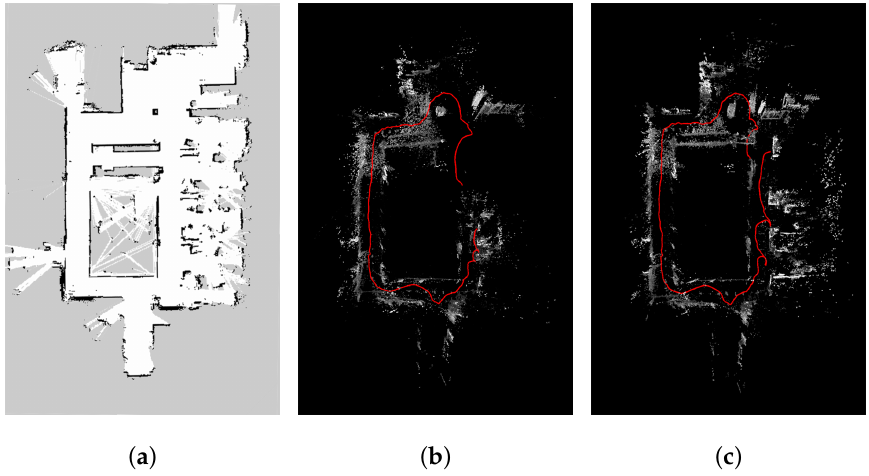
Figure 8. The visual odometry results of a sequence captured by a stereo camera. ( a ) The recon- structed map of an office by laser radar. ( b ) The reconstructed map by Reference [11]. ( c ) The reconstructed map by our